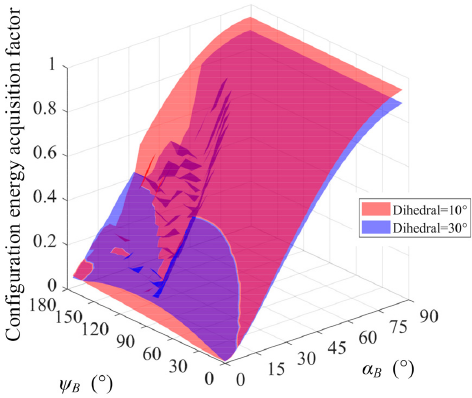
Figure 16. Energy acquisition factor versus α B and ψ B .